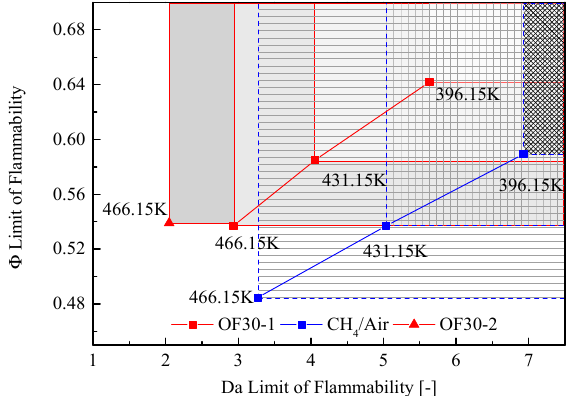
Figure 13. Da and Φ boundary limits of flammability.